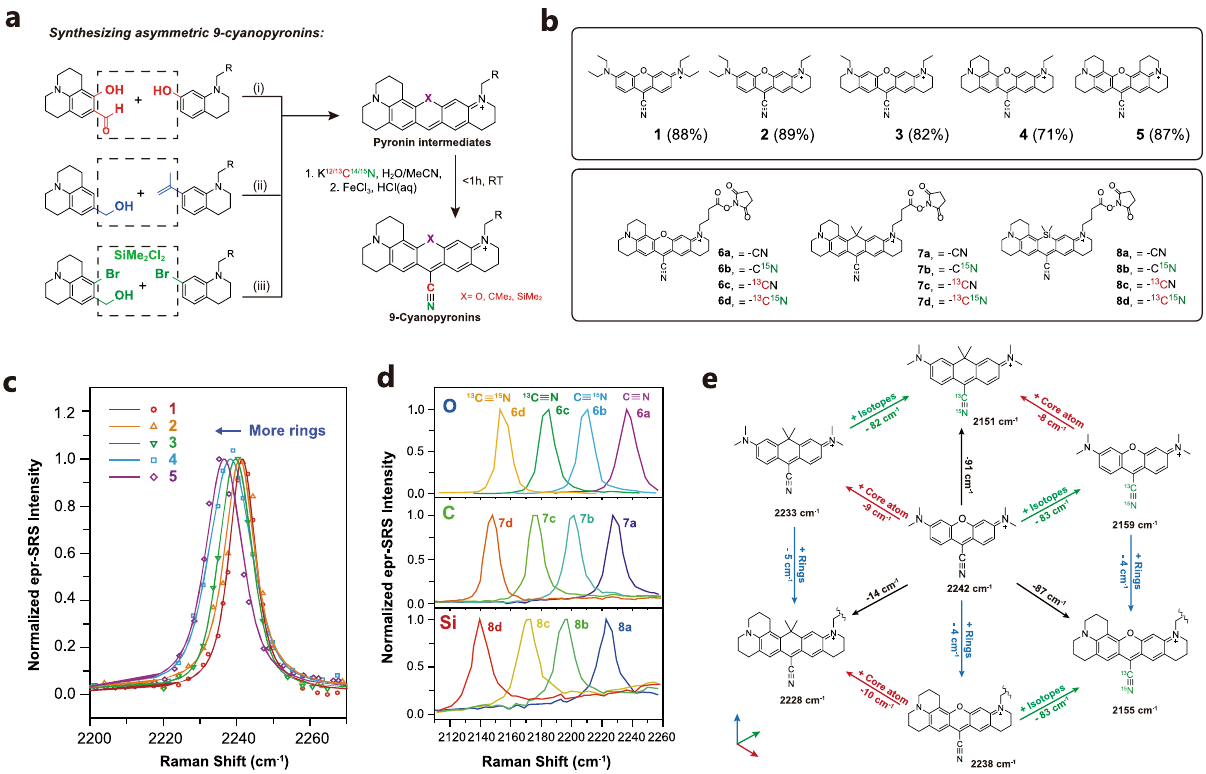
Fig. 2 Synthesis and spectroscopic study of model MARS probes. a Synthetic methods to build asymmetric 9-cyanonpyronins. Reaction conditions: i. H 3 PO 4 , 90 °C, overnight. ii. (1) BCl 3 , DCM, overnight; (2) H 3 PO 4 /PPA, 90 °C, 4 h; (3) FeCl 3 /HCl(aq), DCM, 2 h. iii. (1) BCl 3 , DCM, overnight; (2) n-BuLi, THF, − 78 °C, overnight. b Structures of the model compounds used for spectroscopic study. The fi rst set was used to verify the effect of ring expansion and the second set was used for isotope and core atom effect. c Fitted and normalized epr-SRS spectra of compound 1 – 5 at triple bond region. Curves were Voight fi tted to obtain accurate peak positions. d Normalized epr-SRS spectra of compound 6a – d , 7a – d , and 8a – d at triple bond region. e Additivity and commutativity of three individual effects induced by isotope doping, core atom substitution, and ring expansions. The three axis represents three dimensions of structural modi fi cations, which are mutually